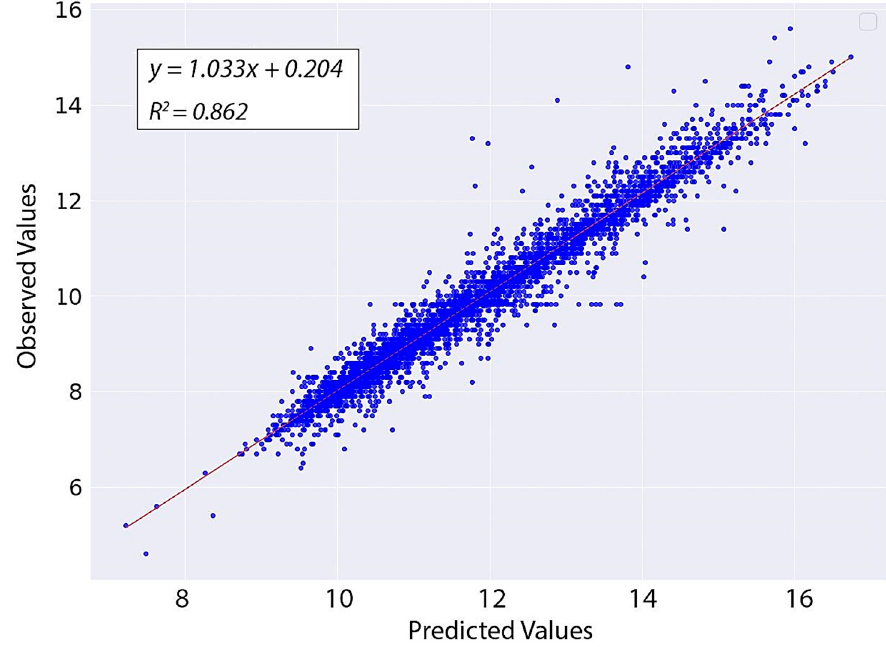
Figure 7. Model performance represented using a scatterplot of the observed and predicted renewable energy production values from the RNN model.